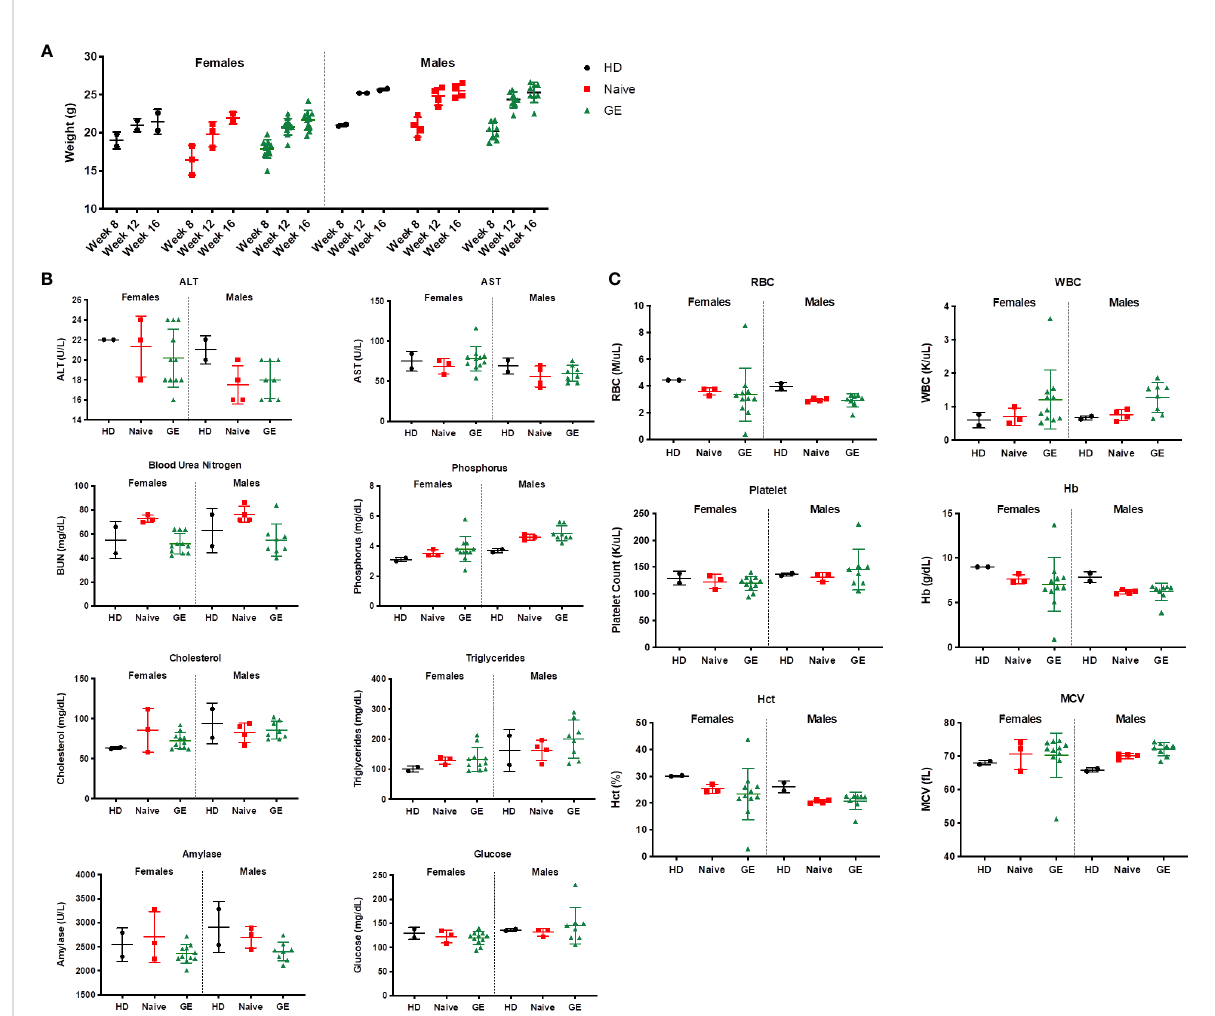
FIGURE 7 Impact of engraftment with GE HSPCs on weight, CBC and chemistry parameters (A) Weight (g) of mice was measured at indicated time points during the safety studies and reported for female and male animals transplanted with HD or with XSCID Naïve or GE HSPCs. (B) Serum from transplanted animals was analyzed at week 16 post-transplant for the different chemistry parameters as indicated on top of each graph. (C) Whole blood was analyzed at week 17 post-transplant for the different hematology parameters as indicated on top of each graph. Each symbol indicates a single